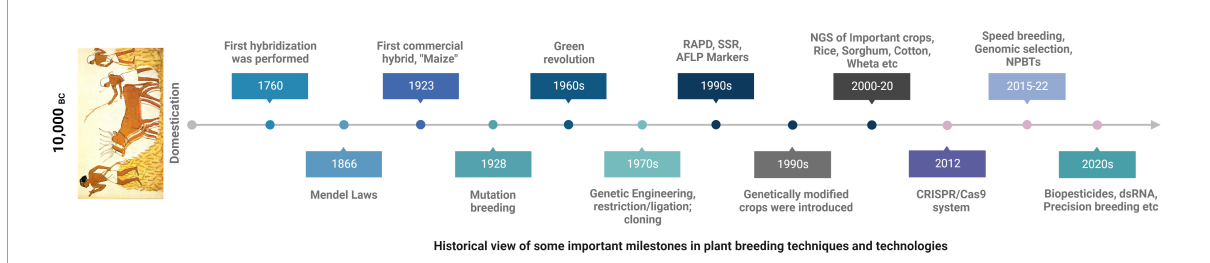
FIGURE3 A timeline of major plant breeding discoveries for crop improvement over the years.